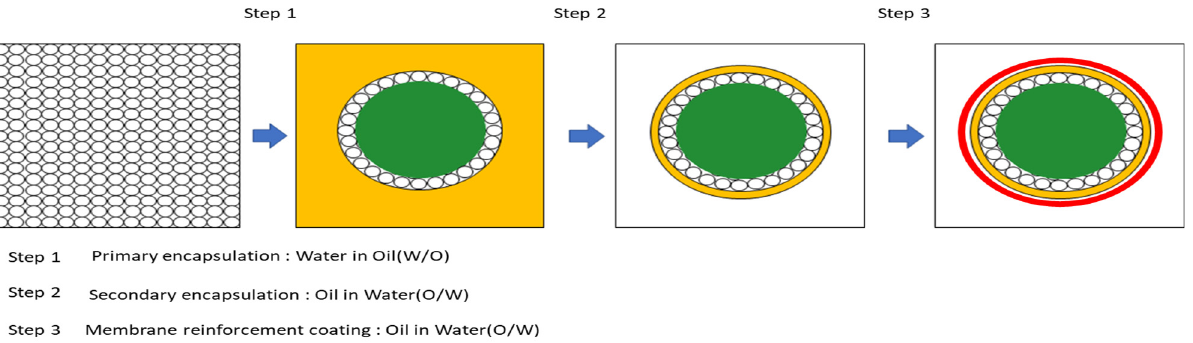
Figure 2. Encapsulation mechanism of MCs.